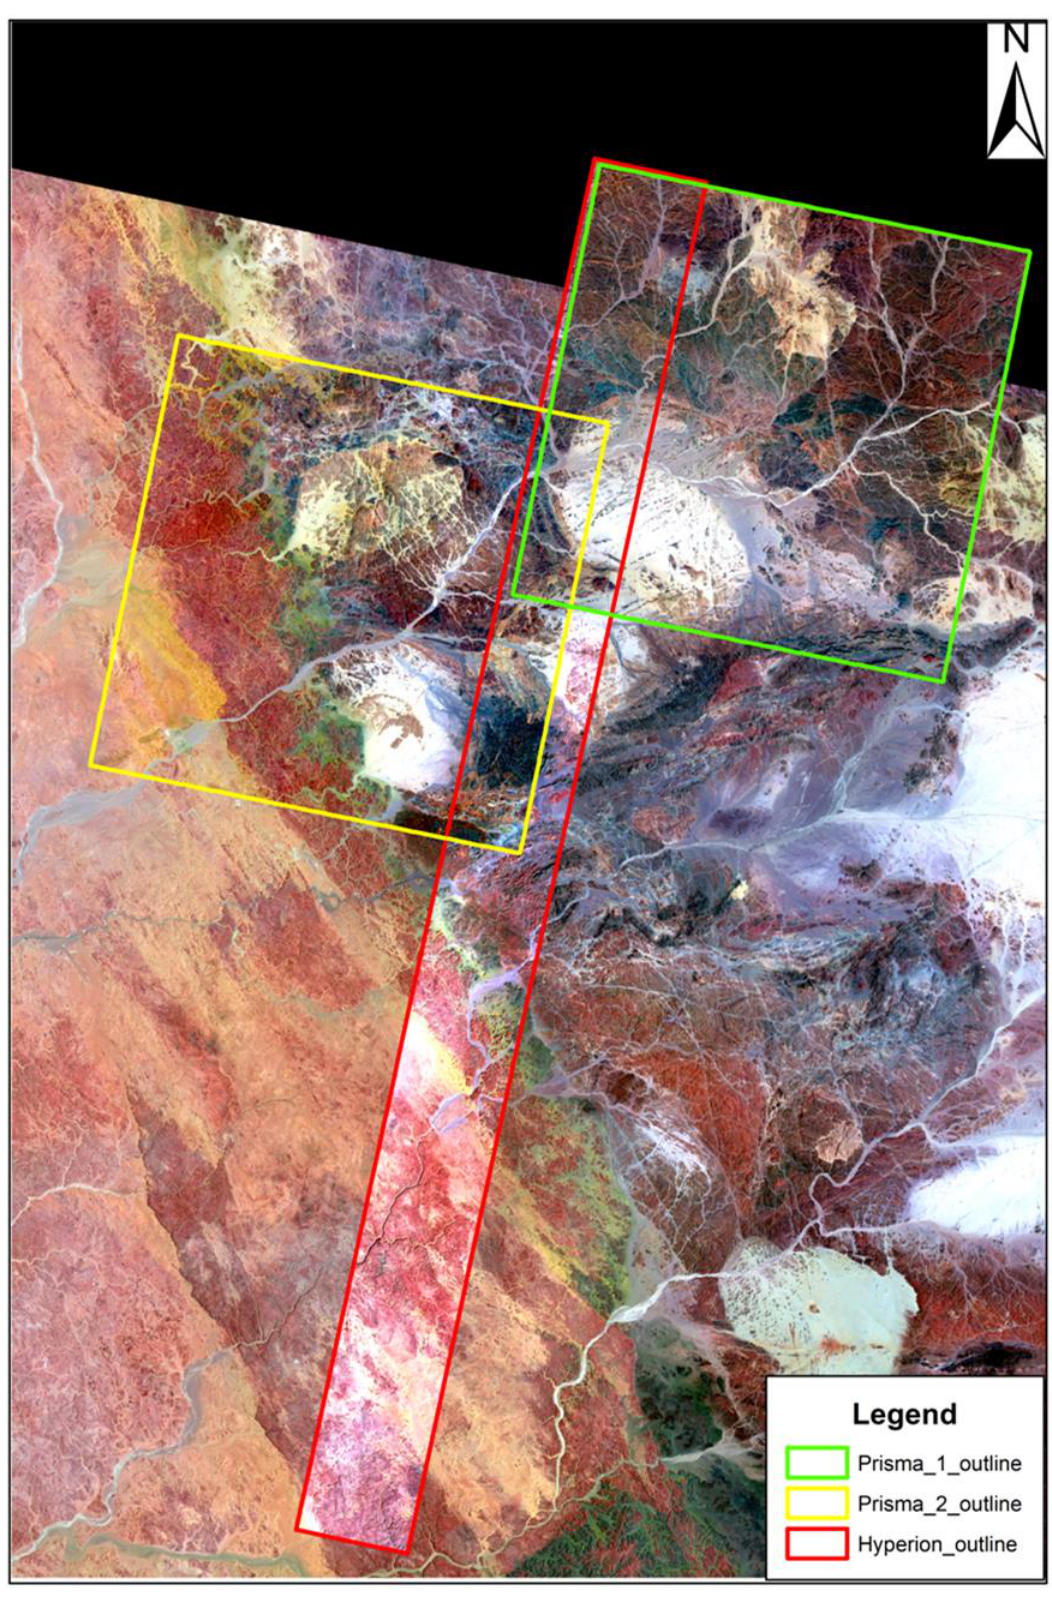
Figure 10. RGB composite of the Hyperion and Prisma bands superimposed on a background of the predicted Hyperion bands.